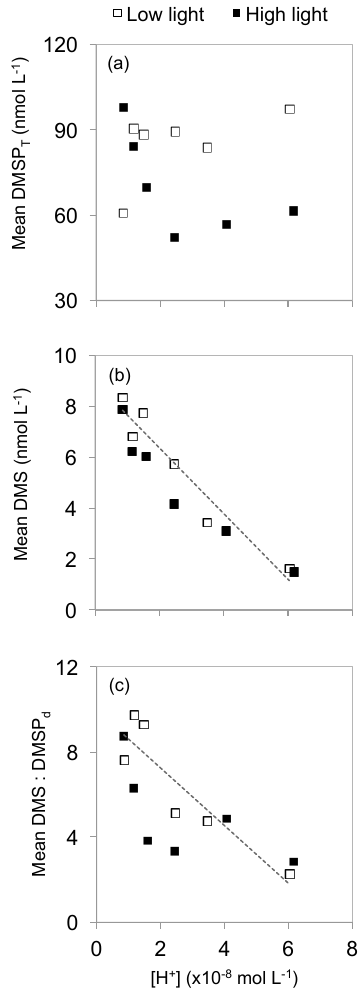
Figure 8. Relationships between the mean proton concentration val- ues ([H + ]) and (a) mean total DMSP concentration, (b) mean DMS concentration, and (c) mean DMS:DMSP d ratio. Values are the mean over the duration of the incubation in each microcosm. Sig- nificant regressions are shown as dashed lines, details of which are given in Table